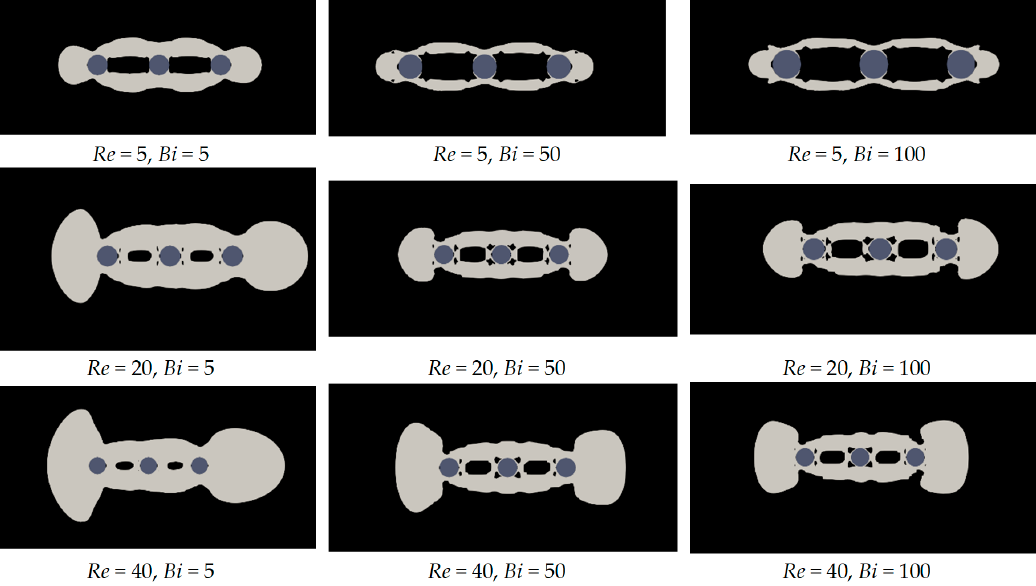
Figure 8. Progressive growth of the unyielded region (shaded) with the increasing Bingham number and decreasing Reynolds number where separation distance d = 3.0 D .